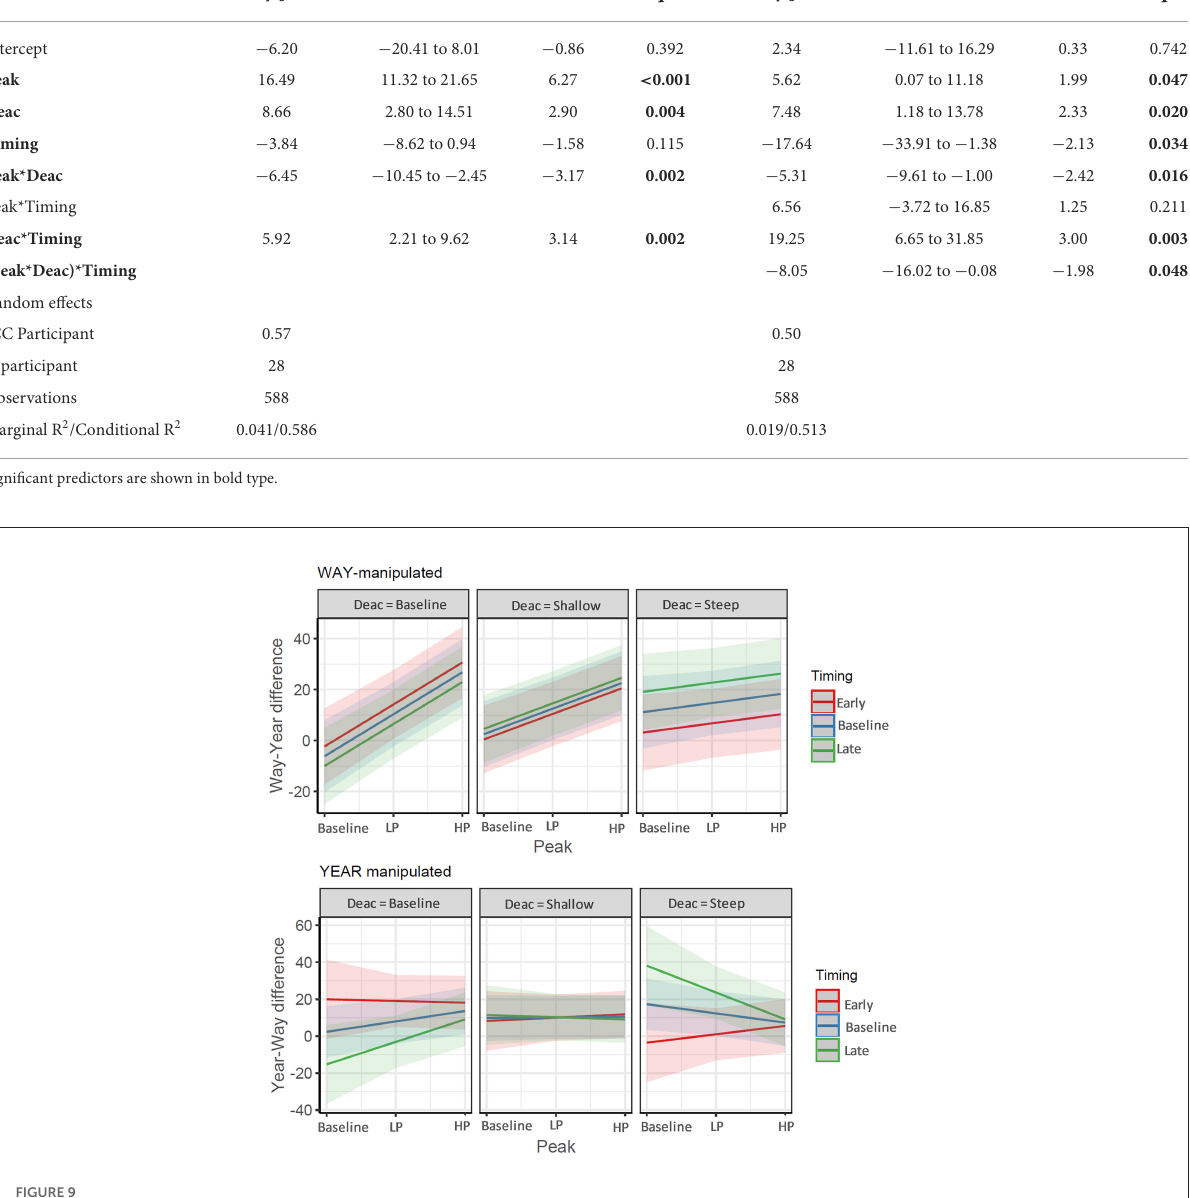
FIGURE9 Predicted values of difference in the relative prominence of WAY and YEAR in the same utterance (Test 2). Shown are the interactions of peak, timing, deaccentuation types of manipulations. Shaded areas represent 95% confidence